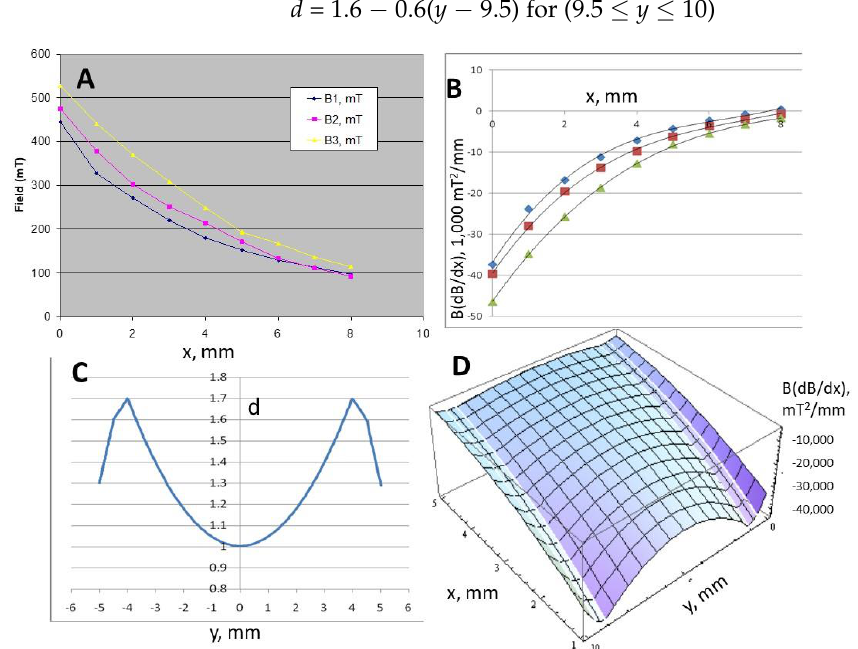
Figure 5. Magnetic field analysis. ( A ): Measured magnetic flux density B outward from the center of the pole pieces of magnets 1, 2 and 3. ( B ): Ponderomotive force versus distance from the poleface of each of the three magnets; negative value indicates the force’s direction (negative x velocity). The ordinate is in units of 1000 mT 2 /mm, negative because it is attractive. ( C ): Multiplier d for Equation (9) as a function of radial distance from the center of the magnetic pole face. ( D ): Magnetic ponderomotive force field as given by Equation (10), where d is a function of y . Units are mm and mT 2